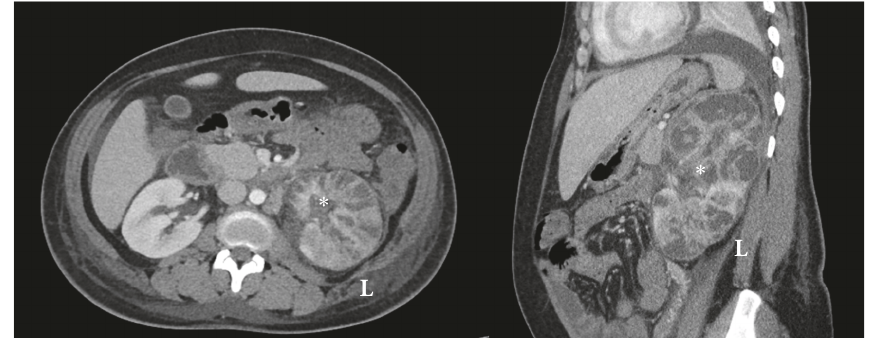
Figure 1: CT of abdomen, axial and sagittal views, with findings of multifocal areas of parenchymal infection and necrosis to left kidney ∗ .